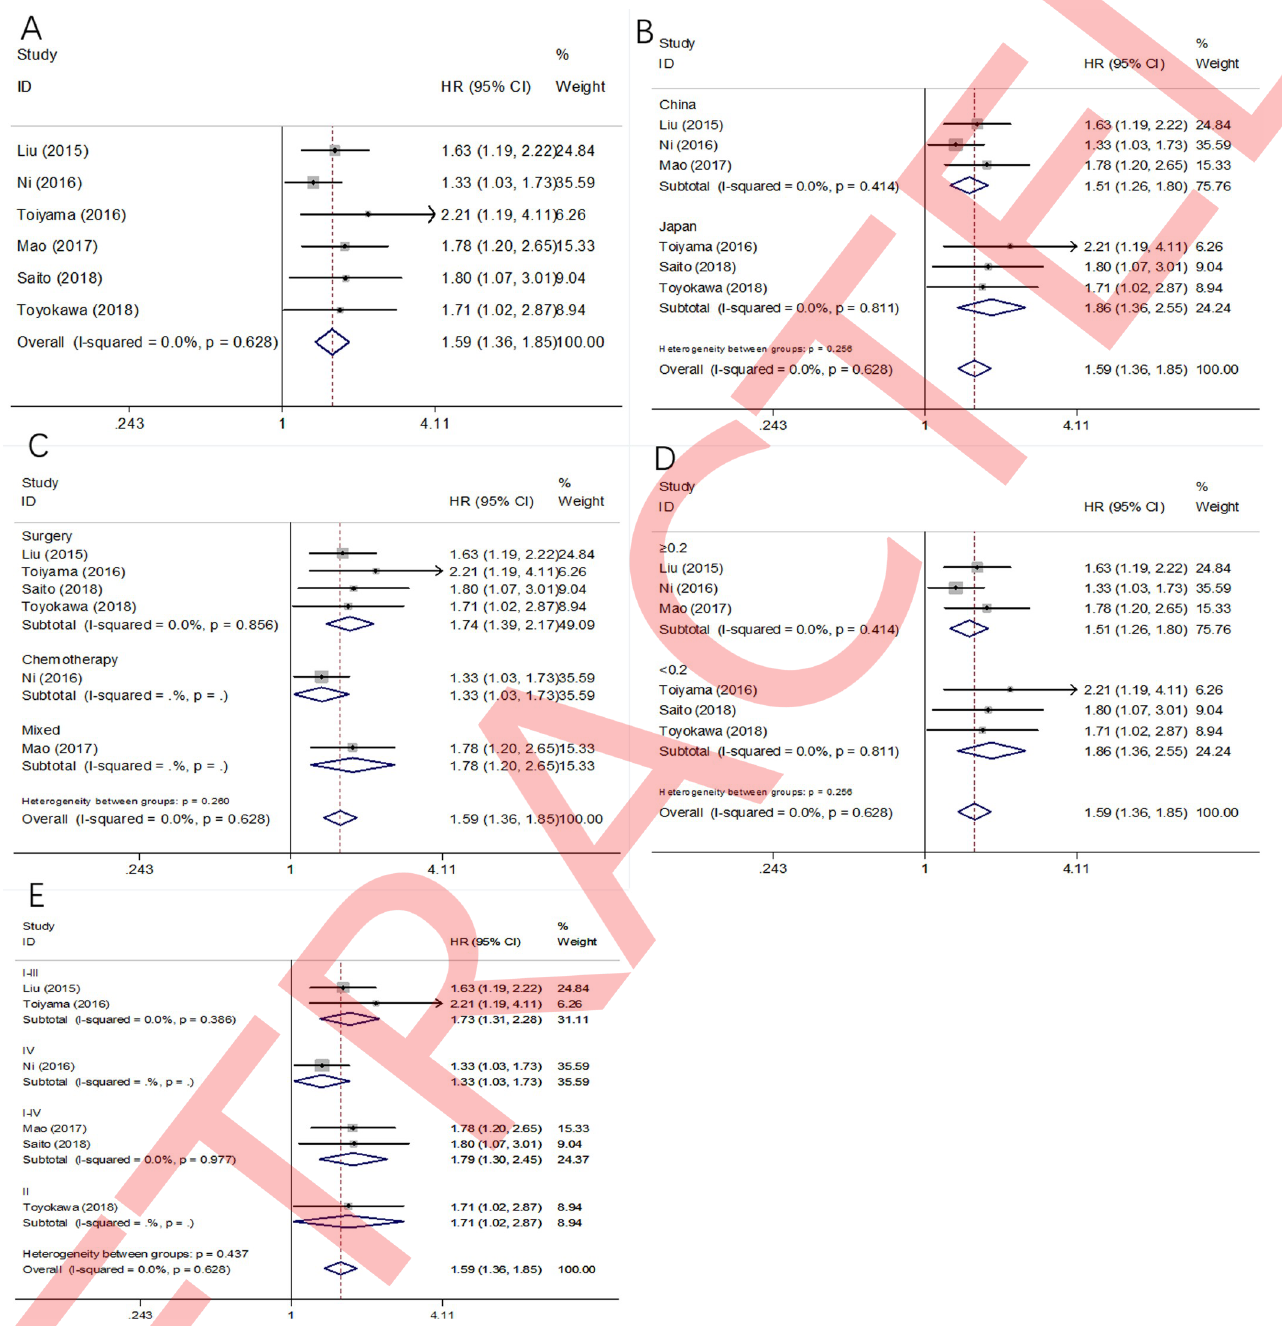
Fig 2. Forest plot of CAR in predicting OS of patients with GC. (A) The whole patients group; (B) The subgroup analysis by country; (C) The subgroup analysis by treatment; (D) The subgroup analysis by cut-off value; and (E) The subgroup analysis by TNM